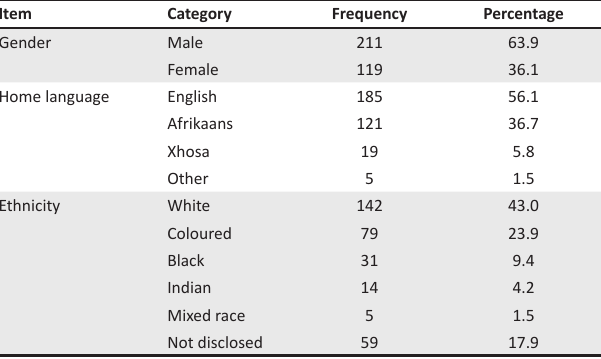
TABLE 1: Demographic composition of the target group/ children 6–7 years ( n =